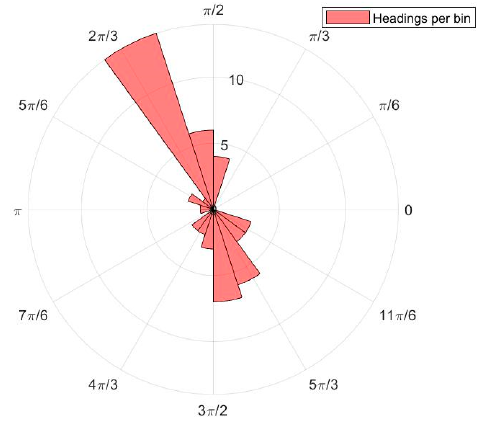
Figure 14. Polar histogram of headings.